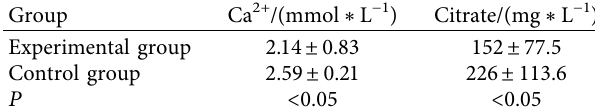
Table 2: Contents of Ca 2+ and citrate in urine of the two groups.